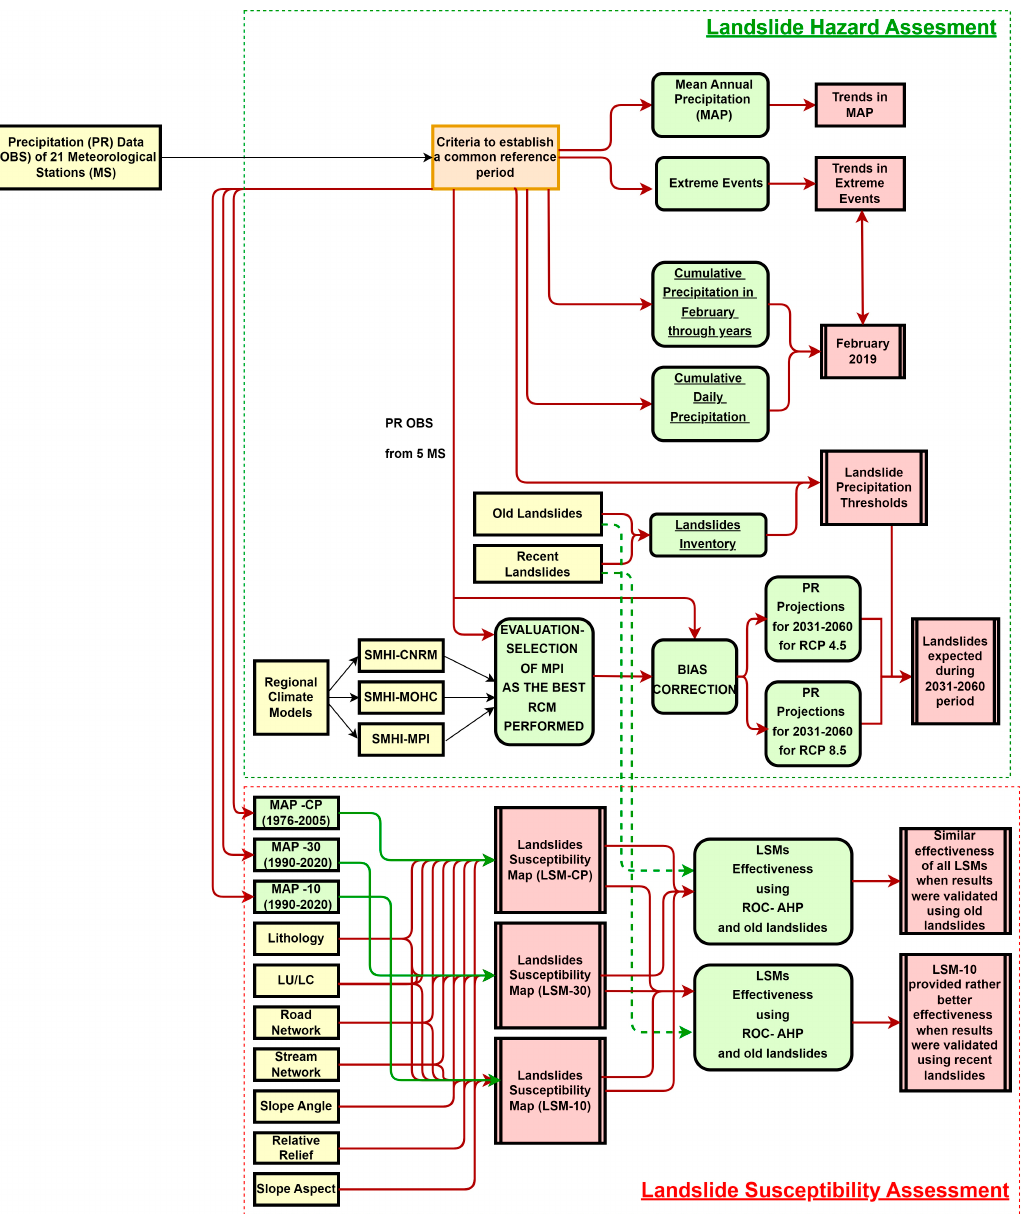
Figure 2. Methodology Flowchart.